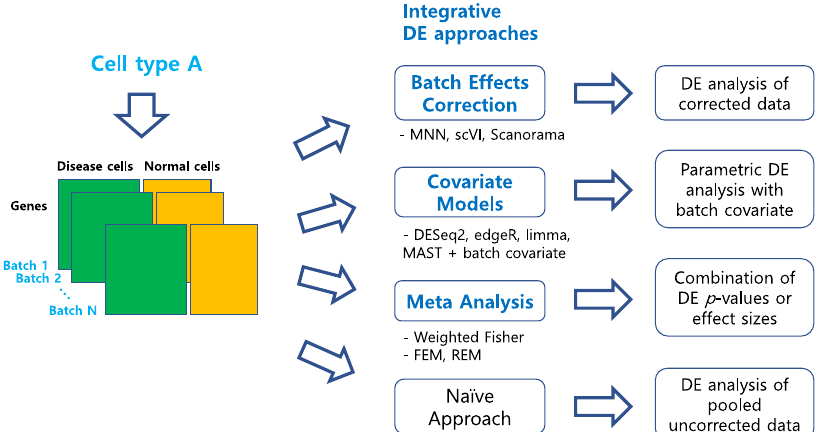
Fig. 1 | An overview of our benchmark study for differential expression (DE) analysis of scRNA-seq data with multiple batches. In total, 46 work fl ows from three integrative strategies and the naïve approach were